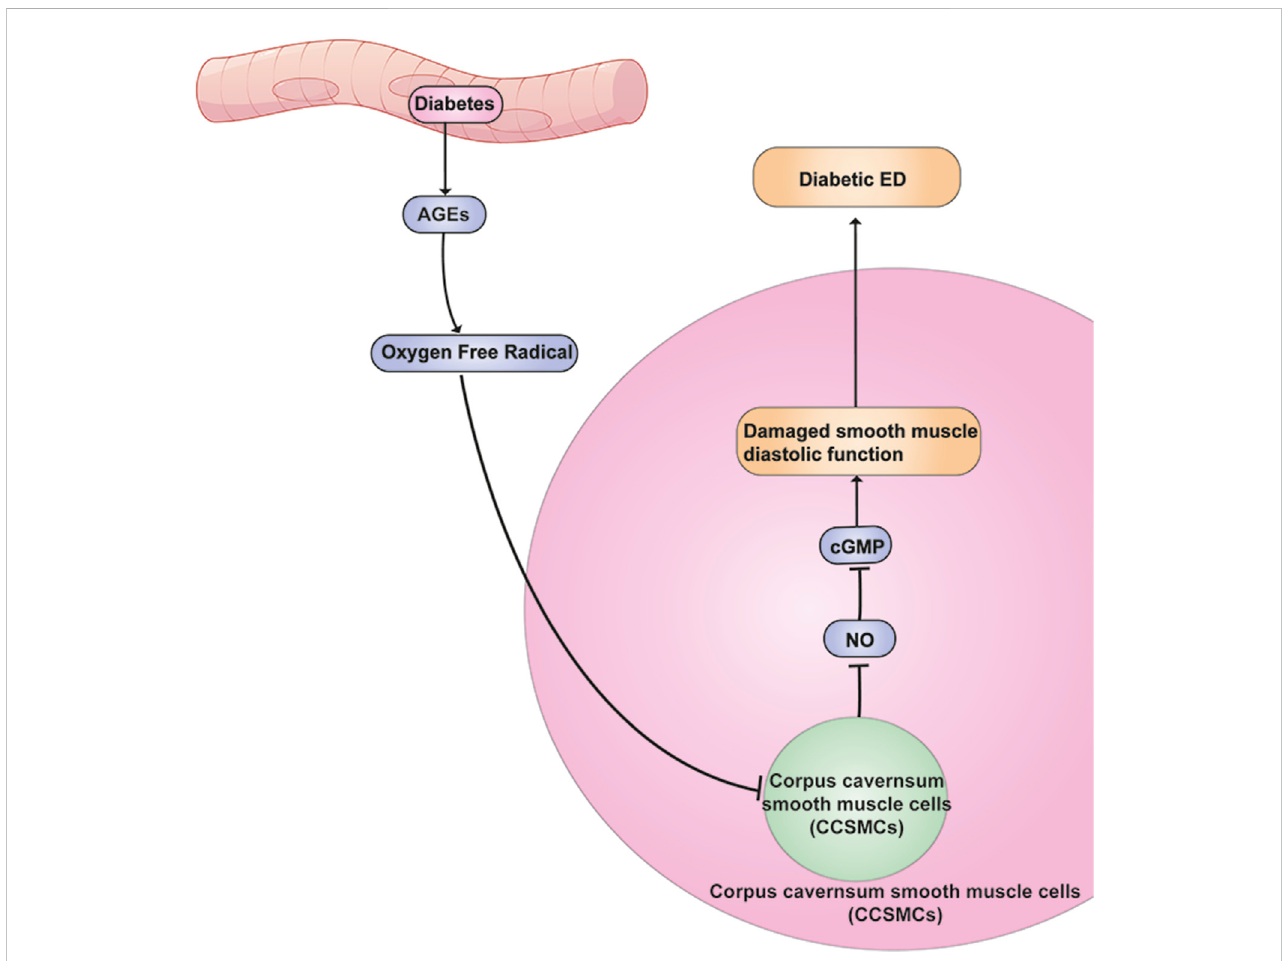
FIGURE 1 Mechanism of chronic hyperglycemia leading to ED. Elevated blood glucose leads to elevated AGEs, and their elevation leads to damage to cavernous smooth muscle cells affecting the diastolic function of this smooth muscle, which in turn leads to ED.